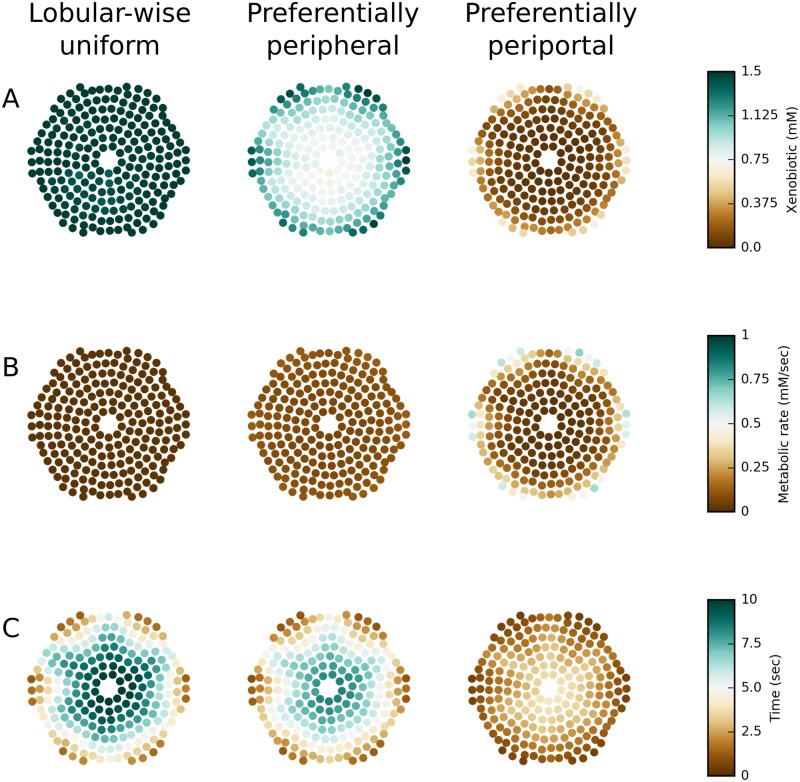
Spatial maps of select steady-state quantities within the virtual liver lobule.(A) xenobiotic concentration; (B) metabolic rate; (C) time for the xenobiotic concentration to reach half of steady-state value. Solid circles indicate the positions of individual hepatocytes in the virtual liver lobule slice. These three simulations have the same transport parameters (α = 1, β = 1/s and D = 1 × 10−6
cm2/s) and only differ in metabolism parameters (from left to middle to right column, CLint = 0.01/s, 0.1/s, 1/s, respectively).